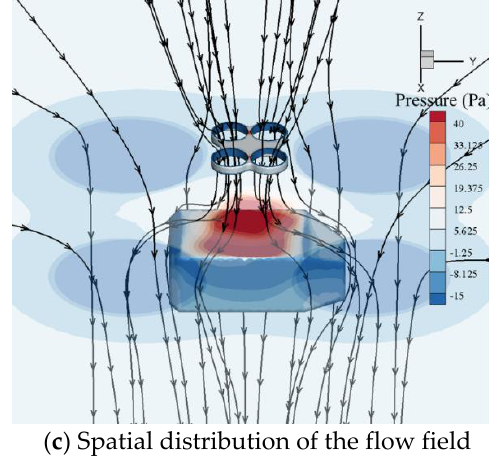
Figure 20. Pressure contours in body interference area.